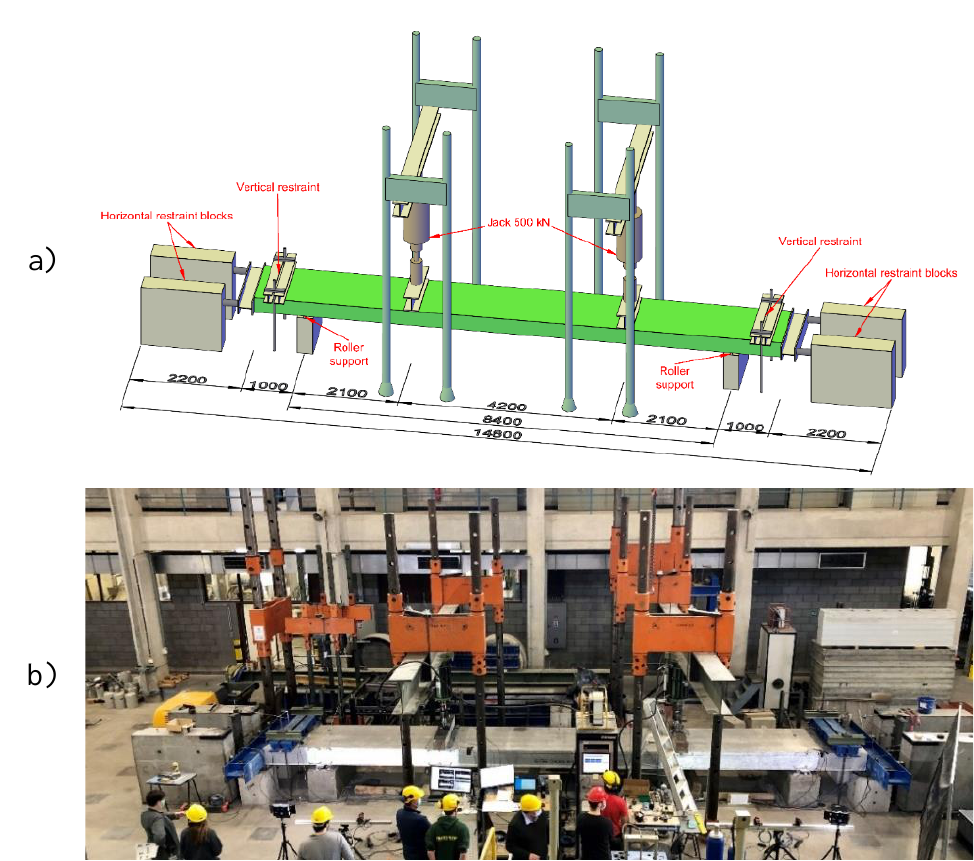
Figure 2: Restrained four-point bending test: (a) Schematic overview (dimensions in mm); (b) picture of the actual test set-up